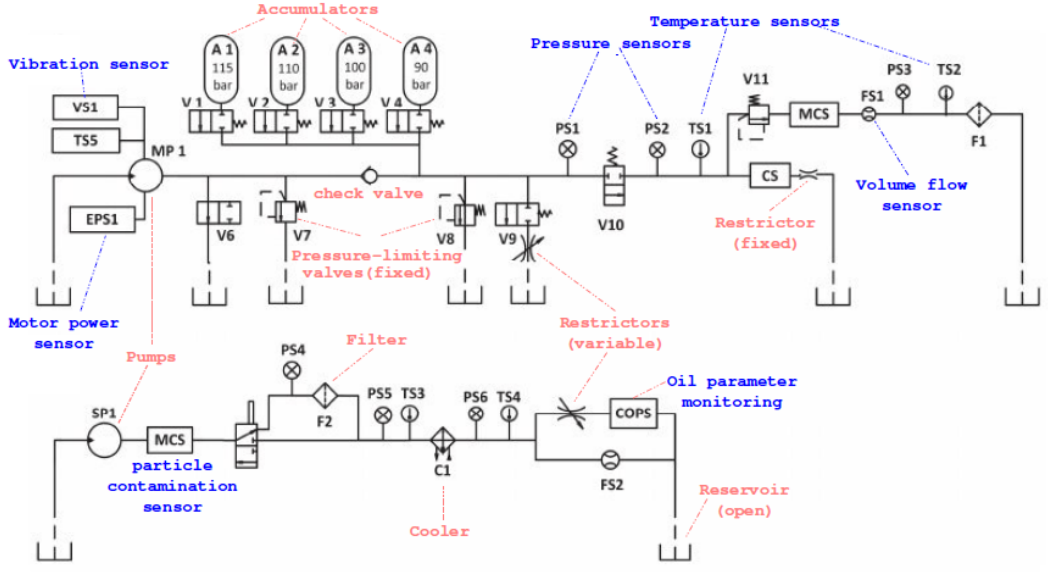
Figure 1. Diagram of the hydraulic test bench (source [15,17]). The upper circuit represents the primary working one which is connected to a lower circuit for cooling–filtration via the oil tank. Sensors are highlighted in